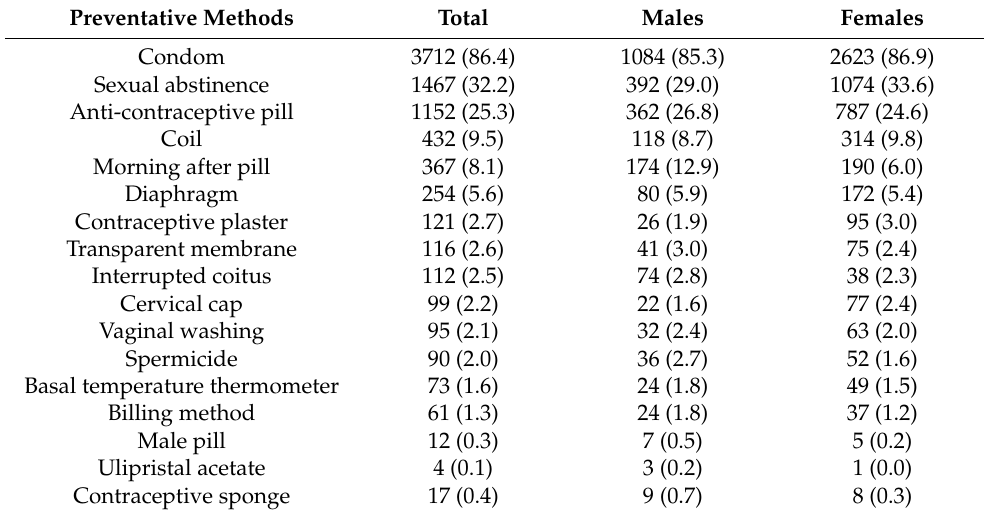
Table 3. Answers to the question: “ Which of the following are the most efficacious methods to prevent sexually transmitted infections? ” (correct answers green marked). Number and percentage (%) of total subjects.